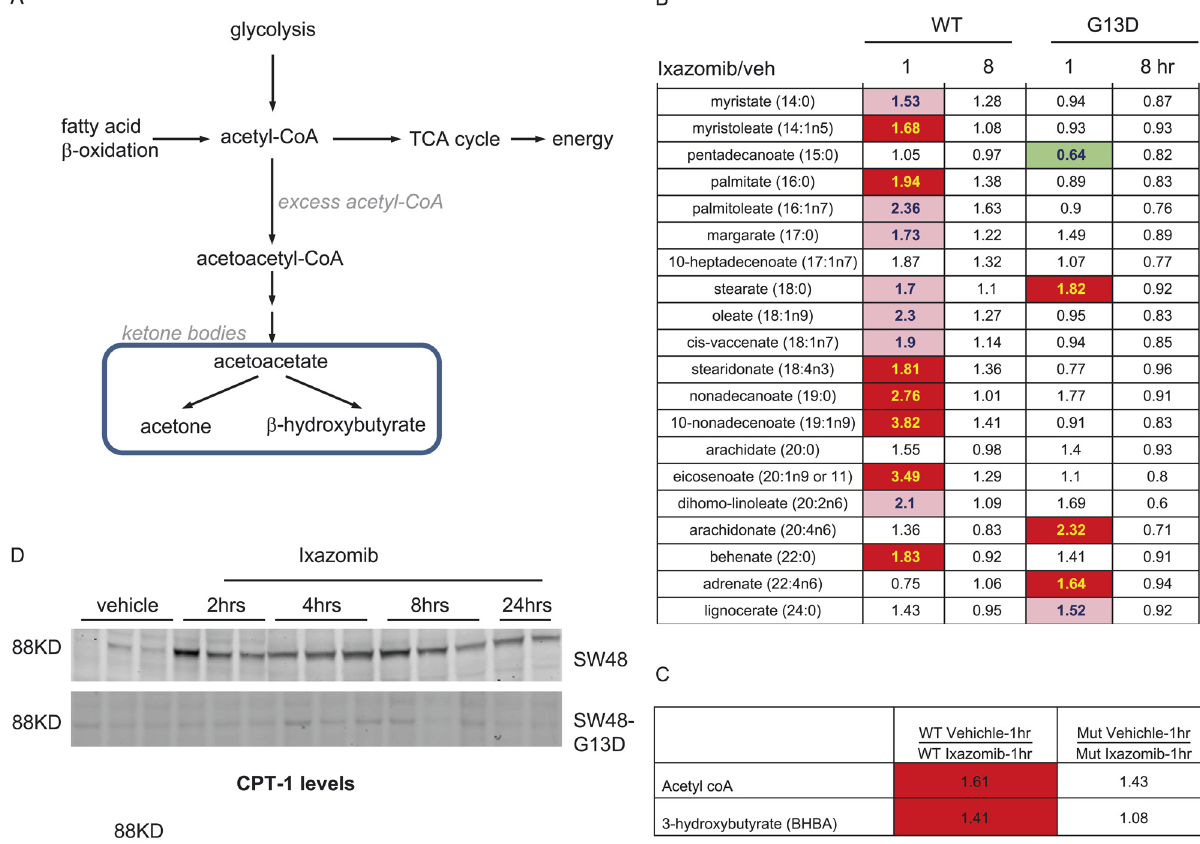
PLOS ONE | DOI:10.1371/journal.pone.0144825 December 28,